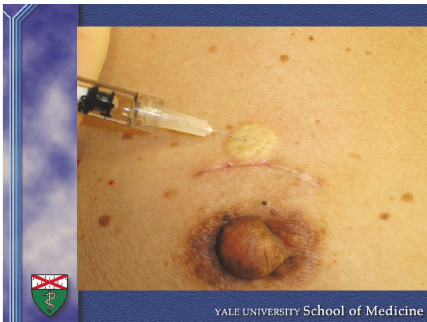
Figure 1: Intradermal injection of Tc-99m above excisional biopsy